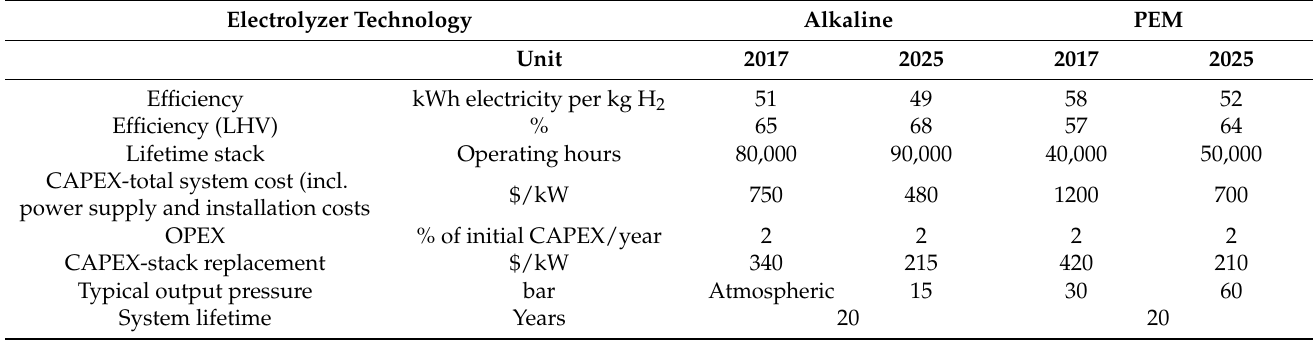
Table 1. Techno-economic characteristics of alkaline and PEM electrolyzers